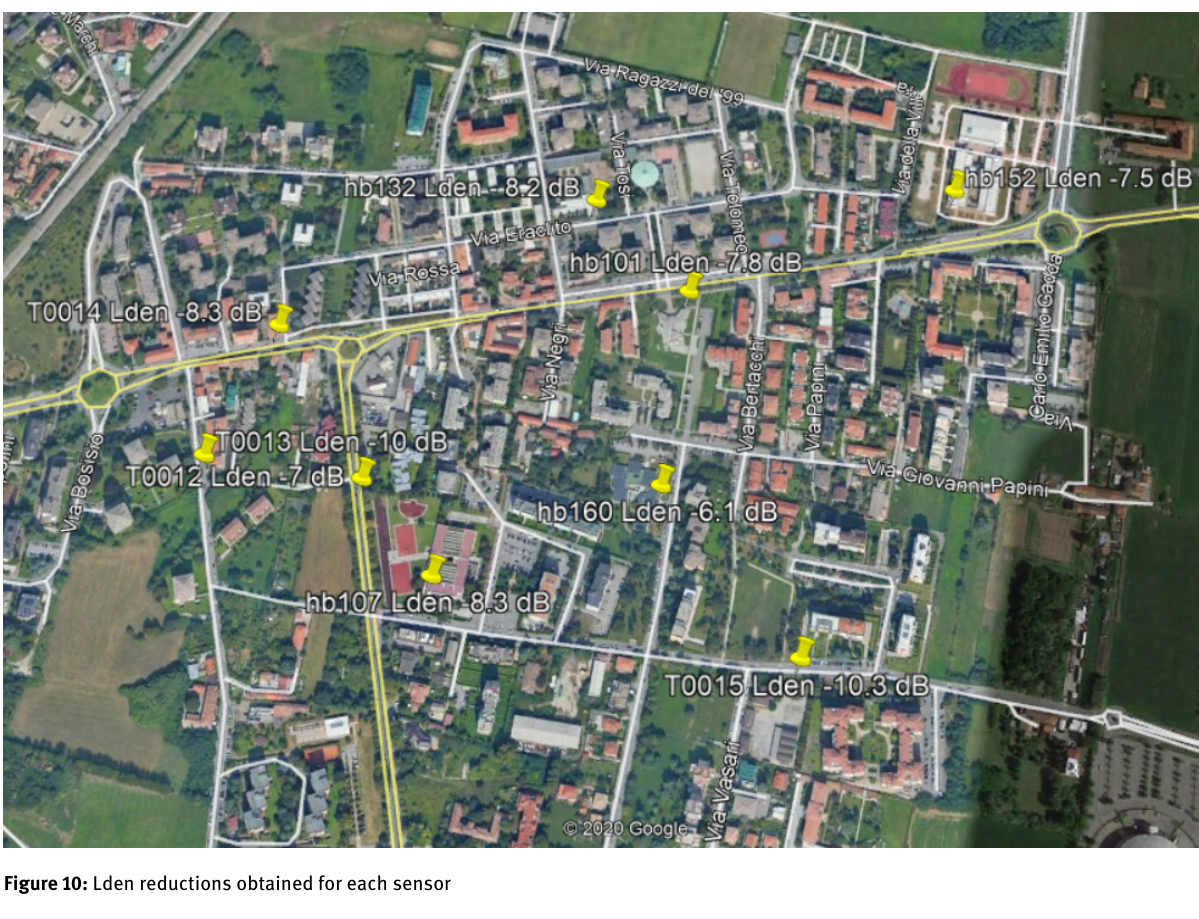
Figure 10: Lden reductions obtained for each sensor